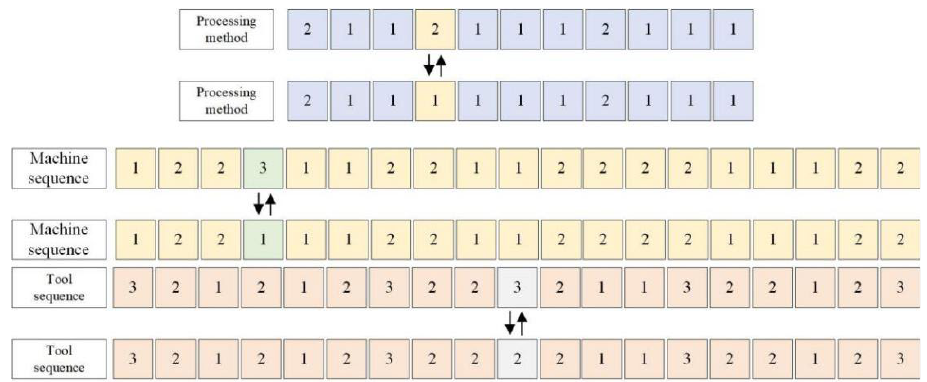
Figure 11. Mutation operation, 3 V .